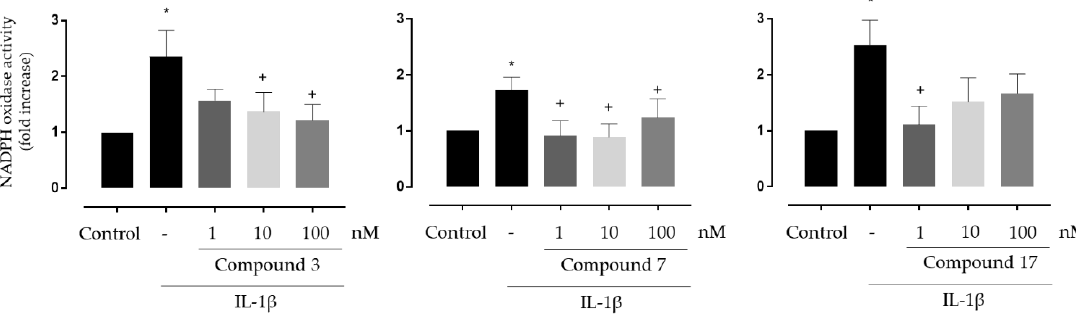
Figure 3. E ff ect of compounds 3 , 7 and 17 on NADPH oxidase activity induced by IL-1 β in segments of Figure 3. Effect of compounds 3 , 7 and 17 on NADPH oxidase activity induced by IL-1β in segments aorta from C57BL6 / J mice. * p < 0.05 vs. control, + p < 0.05 vs. IL-1 β . n = 9 for compound 3 , n = 8 for of aorta from C57BL6/J mice. * p < 0.05 vs. control, + p < 0.05 vs. IL-1β. n = 9 for compound 3 , n = 8 for compound 7 and n = 7 for compound 17 compound 7 and n = 7 for compound 17 .